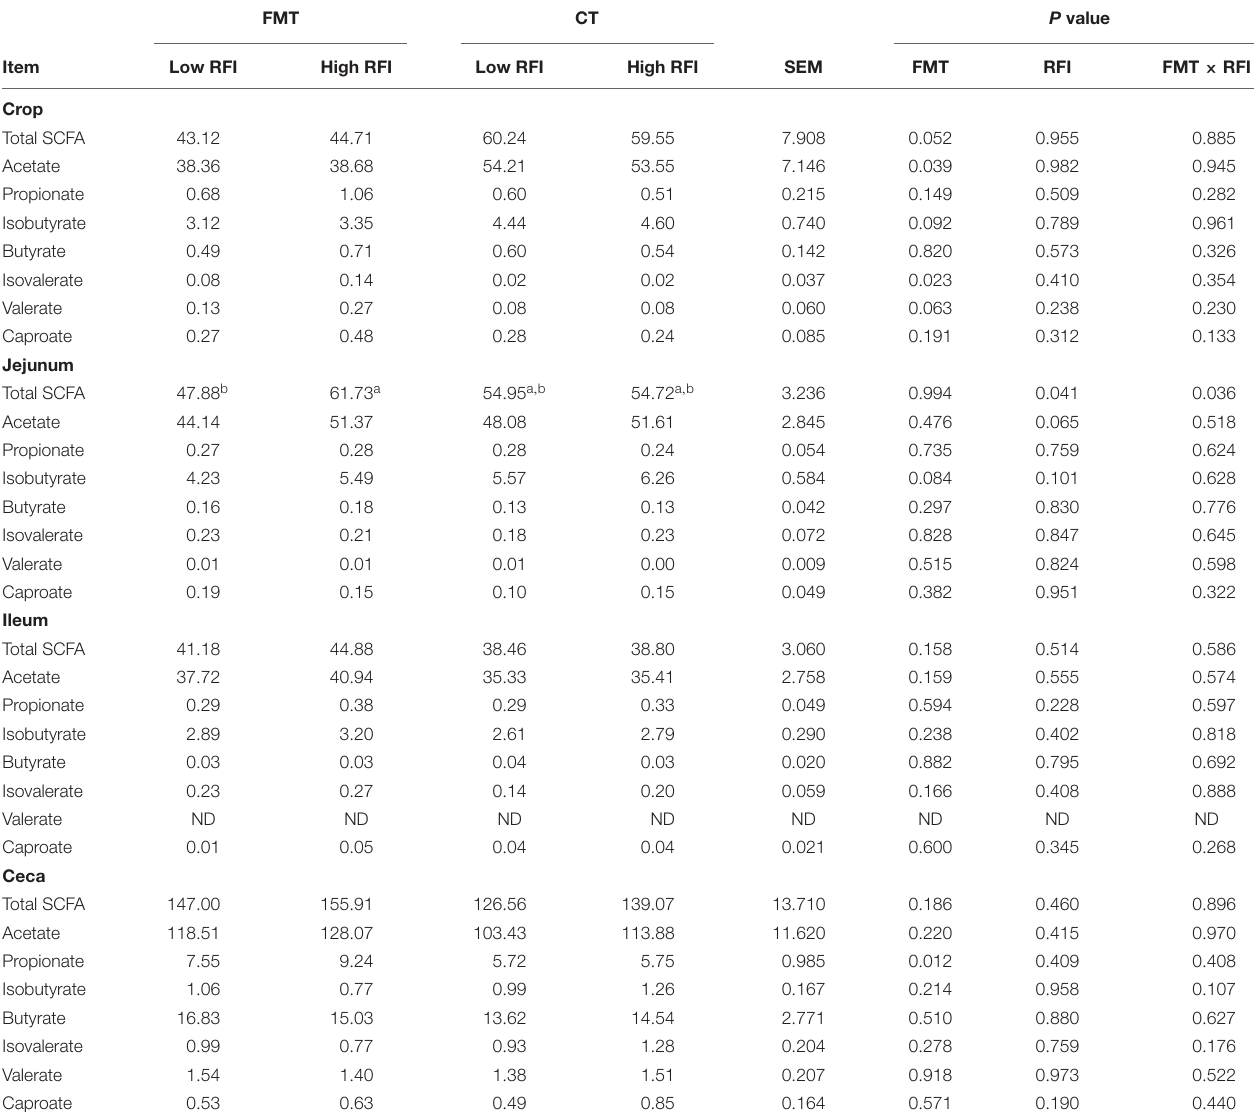
TABLE 2 | Differences in concentrations of short-chain fatty acids (SCFA) in crop, jejunal, ileal, and cecal digesta of low and high residual feed intake (RFI) broiler chickens receiving either a fecal microbiota transplant (FMT) or a control transplant (CT). FMT CT P